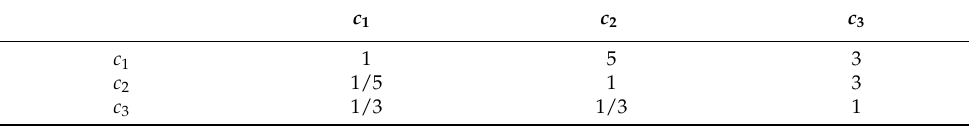
Table 4. Matrix for pairwise comparisons for the main